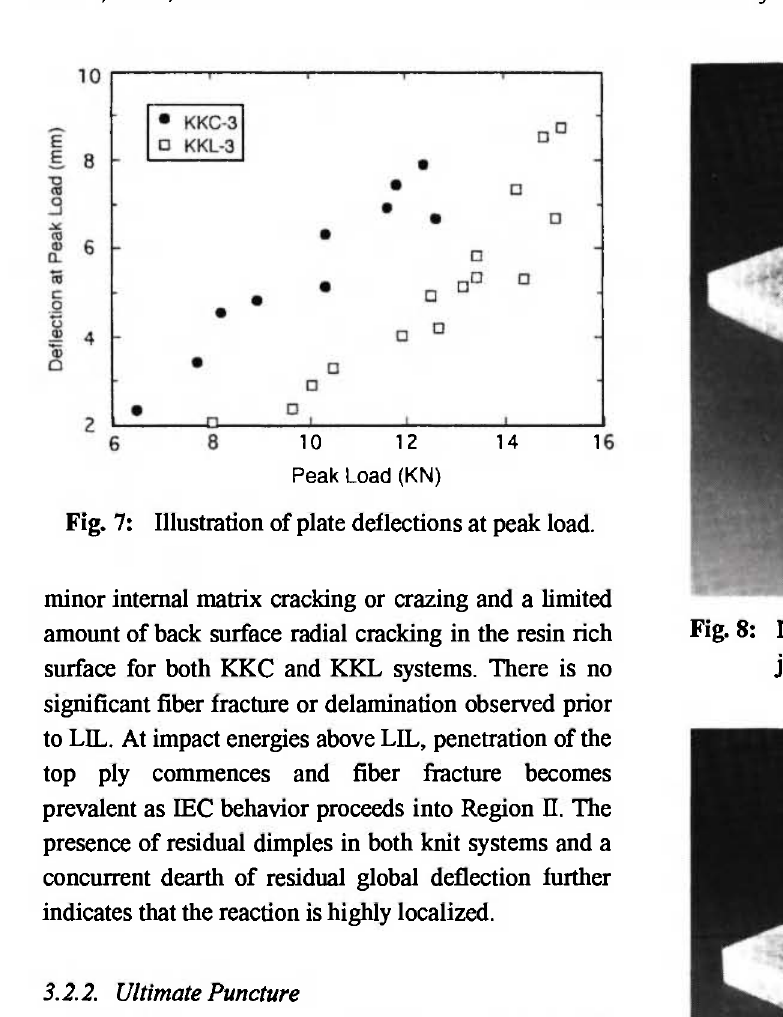
Fig. 8: Damage zone in KKC system following a 133